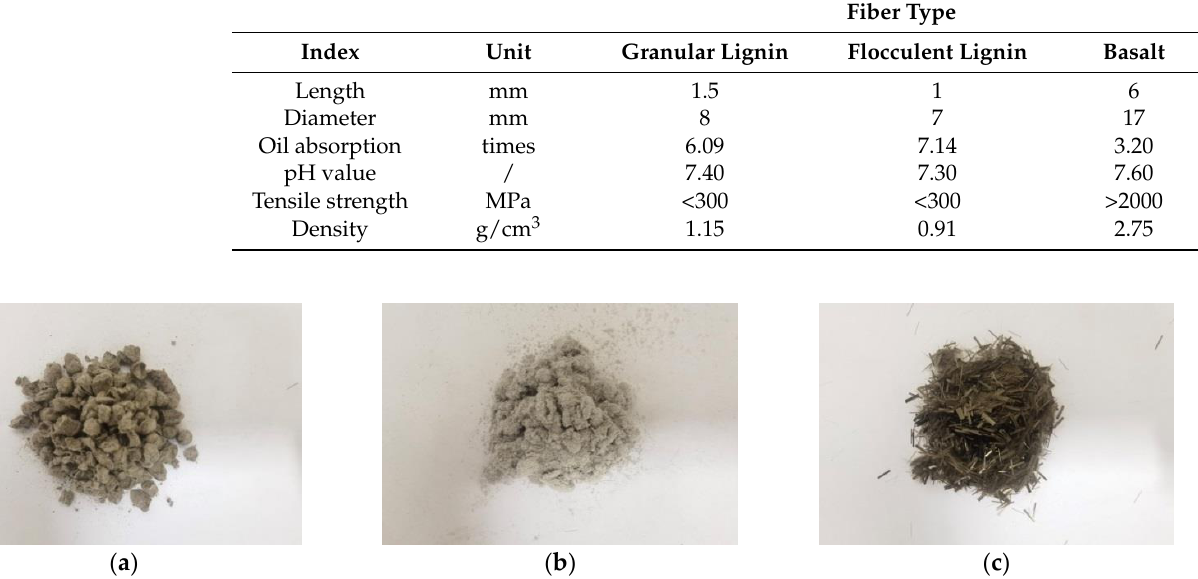
Table 1. Basic performance index test results of the SBS-modified asphalt.